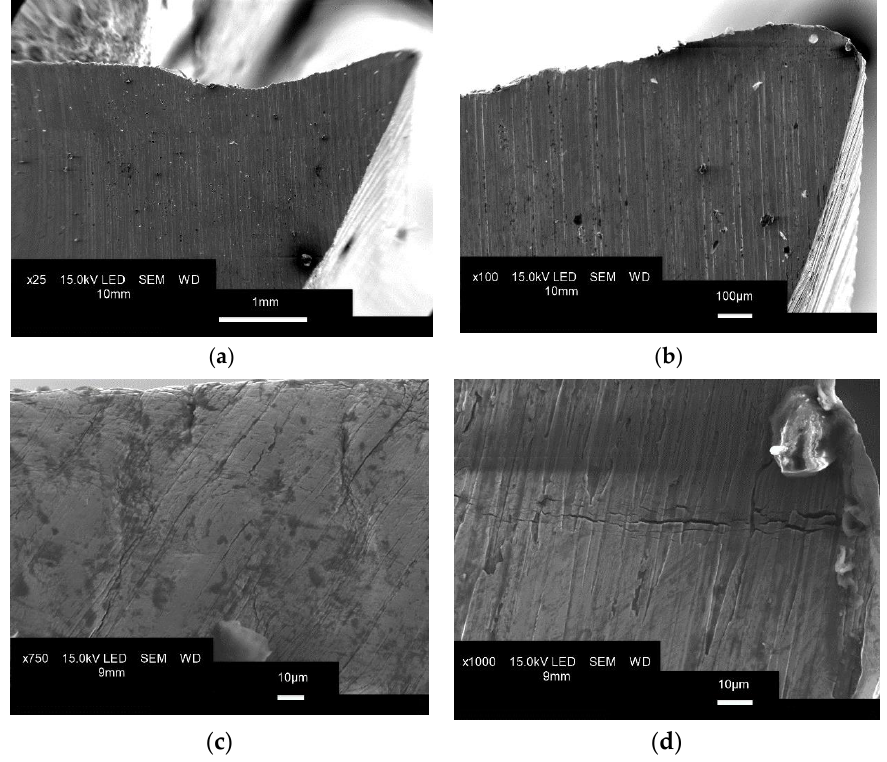
Figure 15. Microscopic images of the rake face magnified ( a ) 25×, ( b ) 100×, ( c ) 750×, ( d ) 1000×. There are visible marks left by the grinding tool and characteristic voids after larger fragments of the surface material were removed during the process. At magnifications of 750× and 1000×, we can see material cracking, which may contribute to faster wear of the tool. Similar defects at the surface of maraging steel 1.2709 were observed by Ži v č ák et al., for specimens printed using DMLS [37].